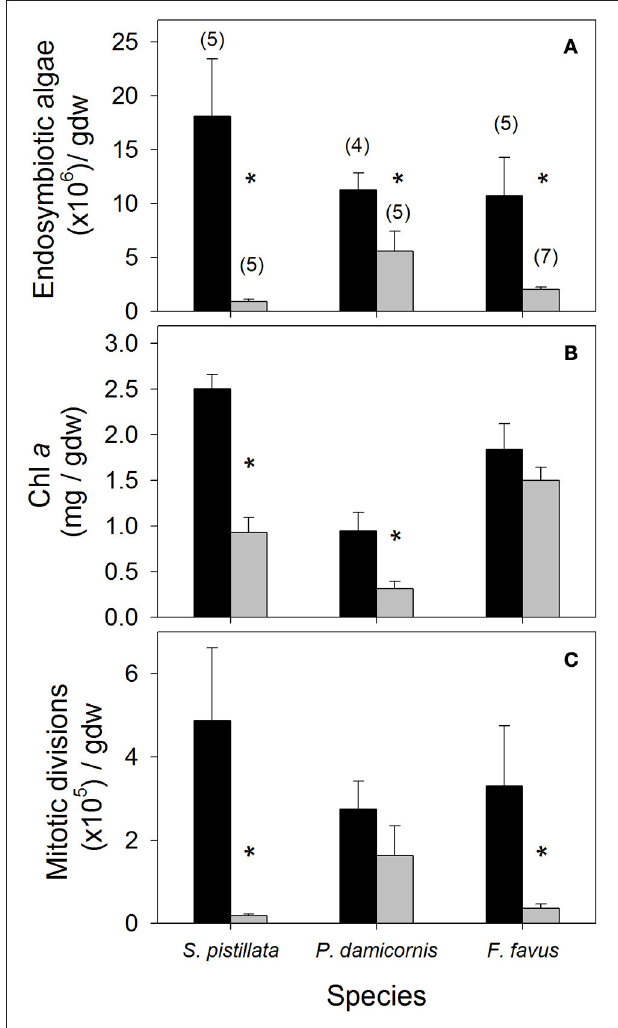
FIGURE 1 | Average (A) endosymbiotic algal density, (B) chlorophyll a (Chl a ), and (C) mitotic division density in control (black bars) and bleached (gray bars) Stylophora pistillata , Pocillopora damicornis , and Favia favus corals. Averages are plotted ± 1 standard error, sample sizes for all panels indicated in brackets in (A) , and significant differences between average control and bleached values within each species are indicated with a *. Corresponding ANOVA results are given in Table 1 . gdw, grams of ash free dry